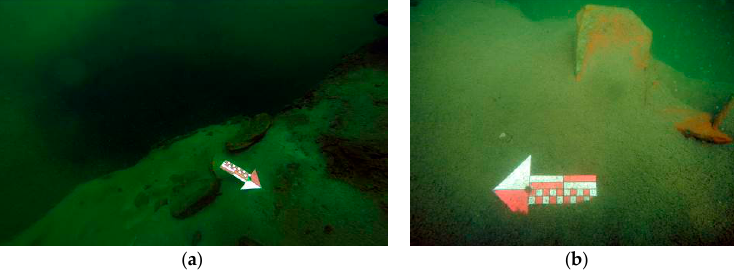
Figure 13. Fragments found during underwater surveys in Lago Tramonto, Gambulaga, Portomaggiore (FE, Italy): ( a ) Dolium ; ( b ) Fragments of pottery (photo by Giovanna. Bucci).